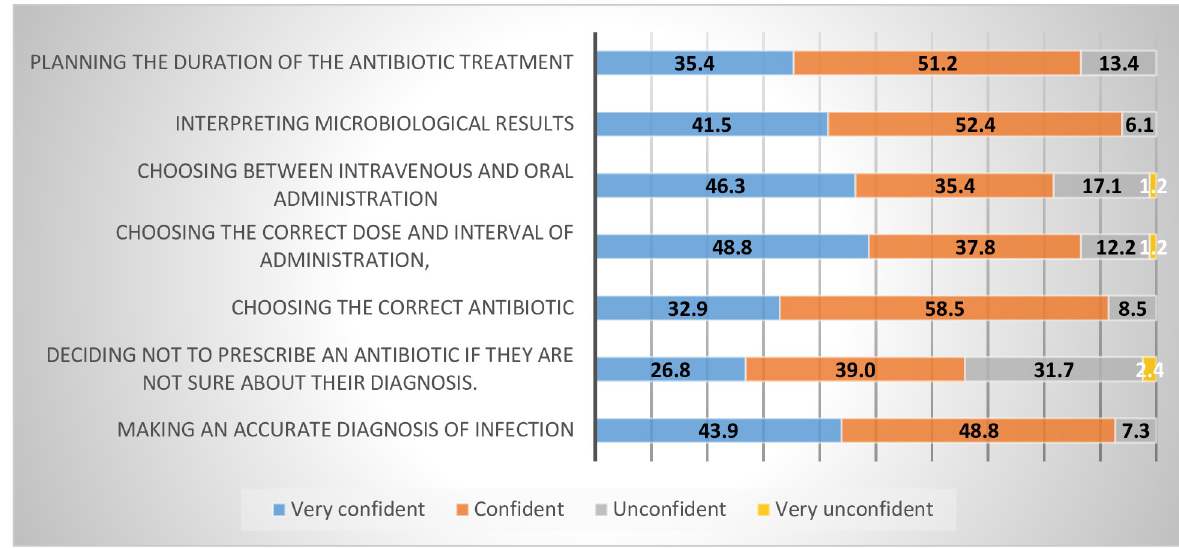
Fig 4. Level of confidence in prescribing the antibiotics, data presented in (%) (n = 92).